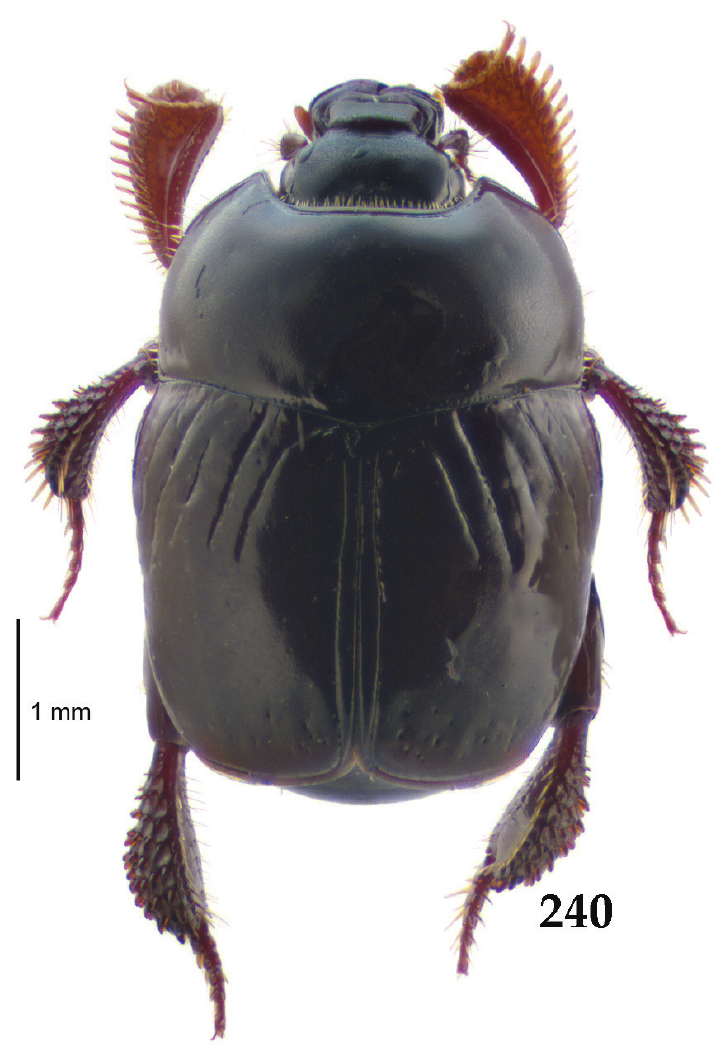
Figure 240. Reichardtia pedator (Sharp, 1876) habitus, dorsal